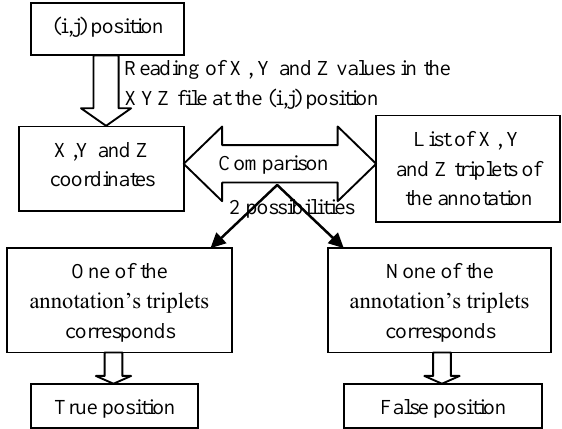
Figure 8: Research of X, Y and Z coordinates of the annotation